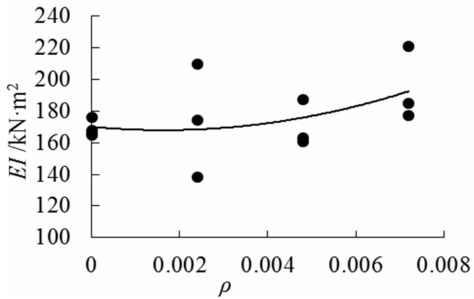
Figure 11. Stiffness–cloth ratios trend